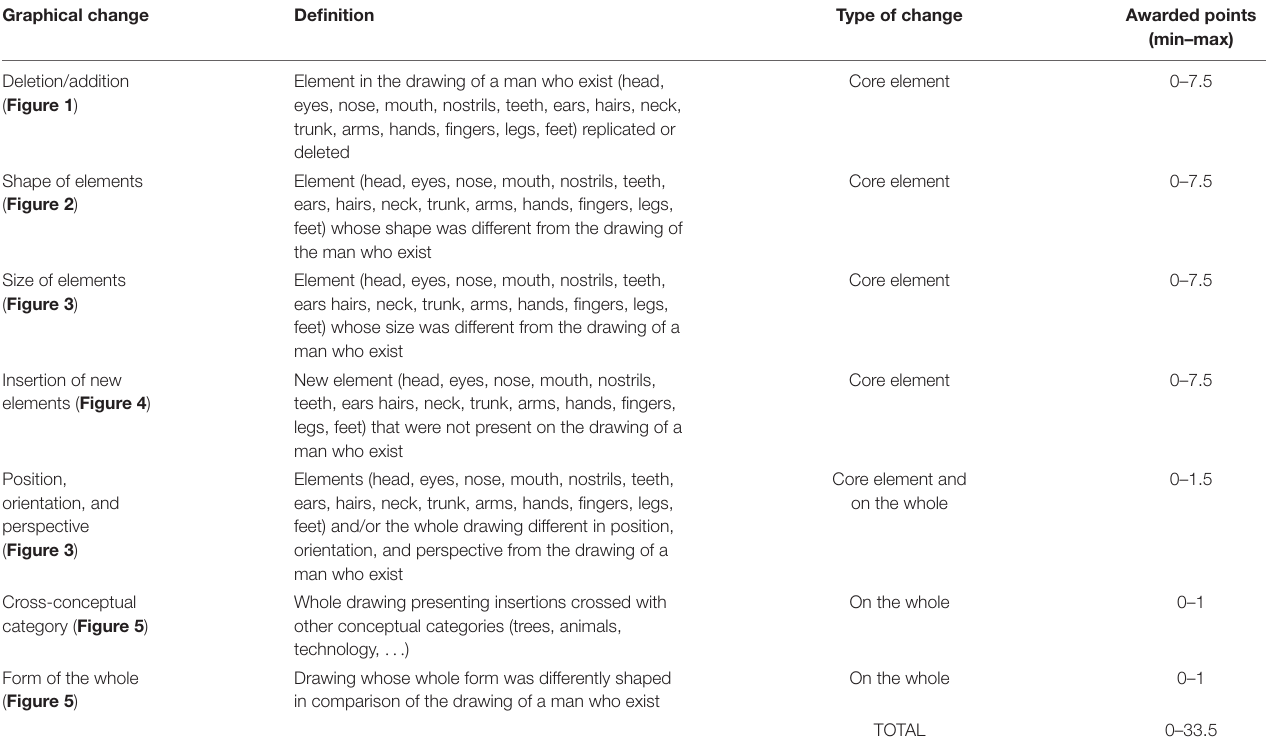
TABLE 2 | Rating scale used to assess originality in drawings.